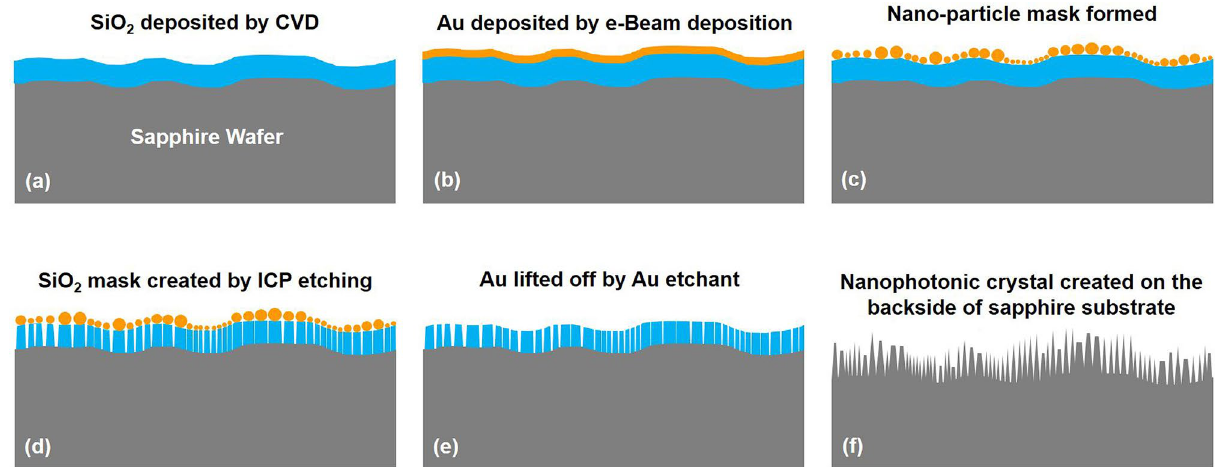
Figure 1. Fabrication process of the NPhC on the unpolished side of SSP sapphire substrate. ( a ) A SiO 2 is deposited on the unpolished side, ( b ) a thin Au layer is deposited over the SiO 2 , ( c ) the first Au nanomask forms under high temperature, ( d ) the Au nanomask was employed to etch the SiO 2 nanomask, ( e ) Au nanomask removed, ( f ) sapphire etched through the SiO 2 nanomask, and SiO 2 removed to leave the final NPhC sapphire substrate.